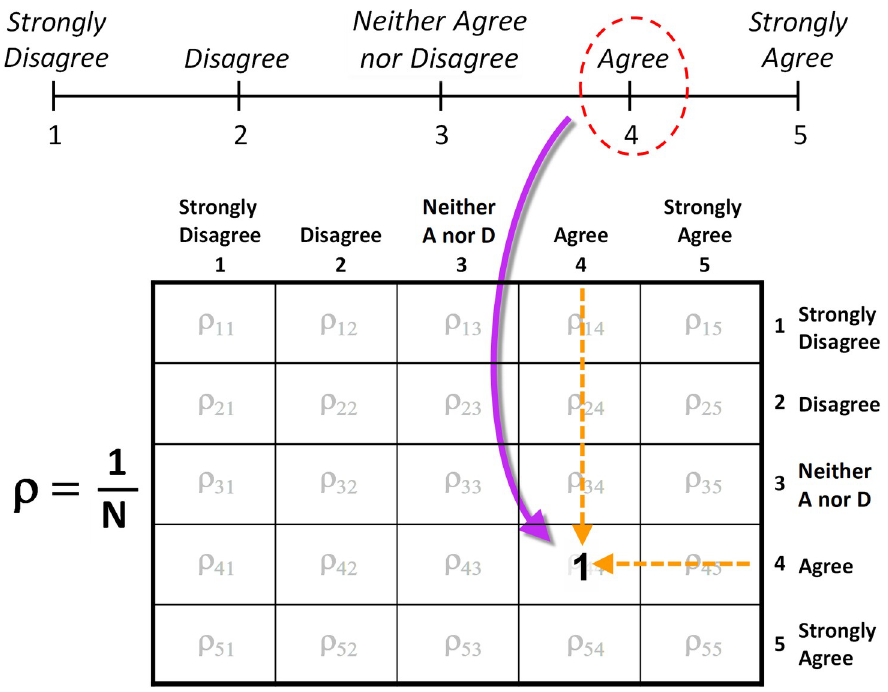
Fig A1. For a single response to a survey item, one full count is placed in the corresponding diagonal box of the square density-matrix array.